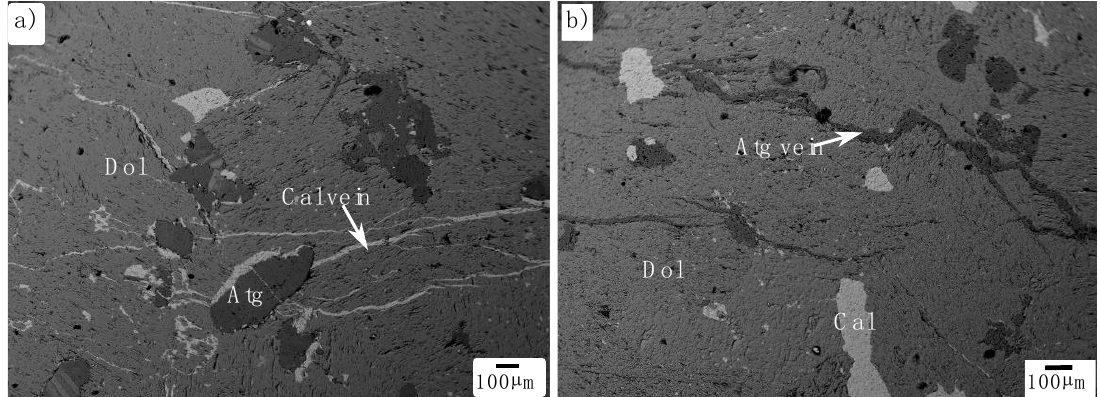
Figure 6. Back-Scattered Electron (BSE) images of the dolomitic marble sample, showing calcite veins and serpentine precipitation in the dolomitic matrix ( a ), and serpentine veins and calcite precipitation in the dolomitic matrix ( b ). Dol—Dolomite; Cal—Calcite; Atg—Antigorite.